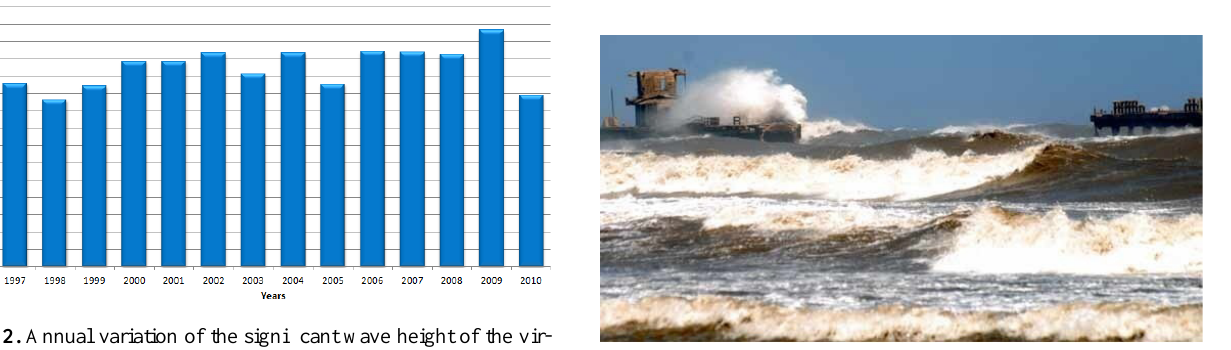
Fig. 13. Maximum values of the significant wave height of the vir- tual buoy.